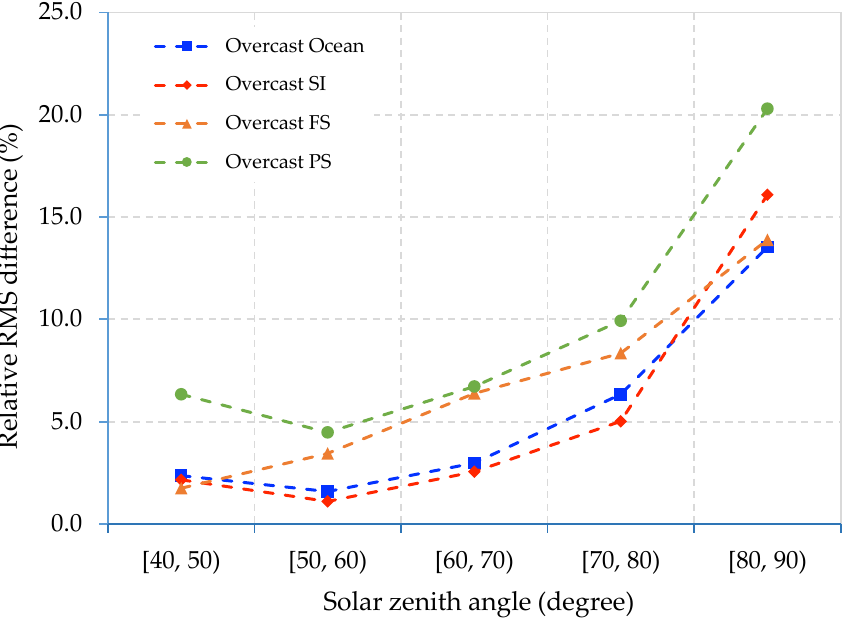
Figure 7. Relative RMS differences (%) of overcast TOA albedo retrieval algorithms between the CERES and MISR as a function of solar zenith angle ranges.